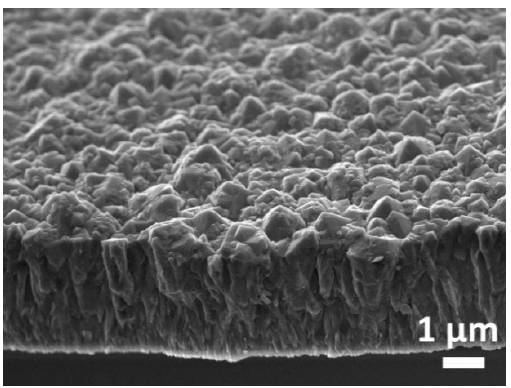
Figure 1. SEM image of the BDD film grown on Al 2 O 3 substrate cross-section (45° angle view). Raman spectra acquired using 325 nm and 633 nm excitation wavelengths (Figure 2) contain maxima typical for heavily boron-doped diamond. Both B 1 (480 cm − 1 ) and B 2 optical phonon confinement due to changes in the diamond structure, respectively